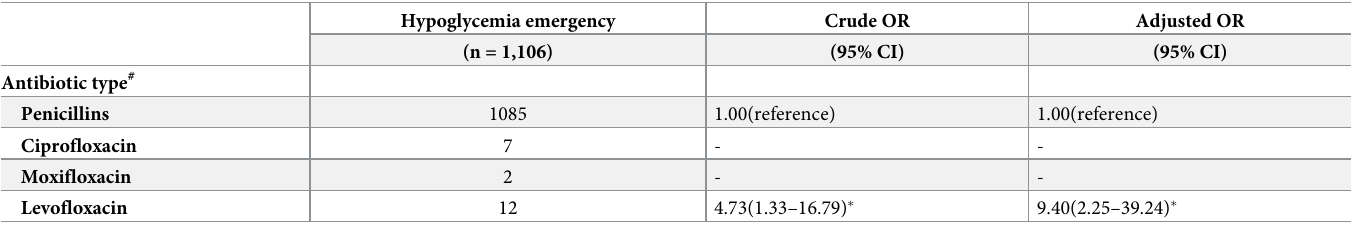
Table 4. Comparison of usage of different types of quinolones and penicillins as exposures towards risk of developing hypoglycemia emergency